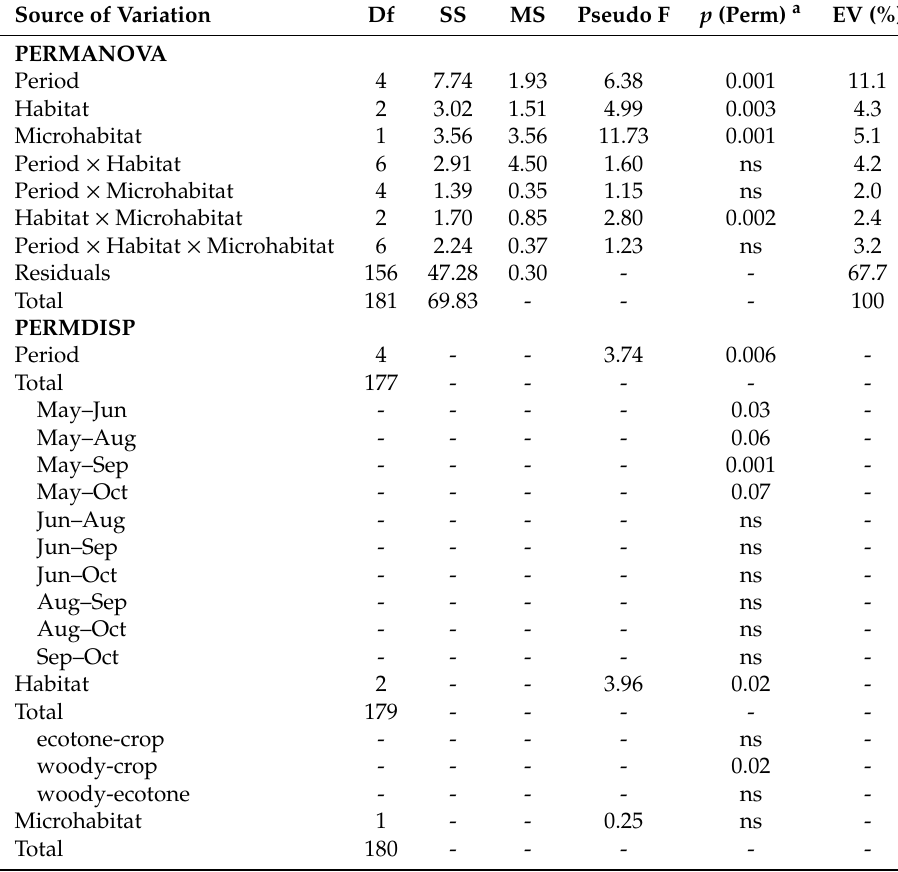
a : boldface indicates statistical significance at p < 0.05; ns = not